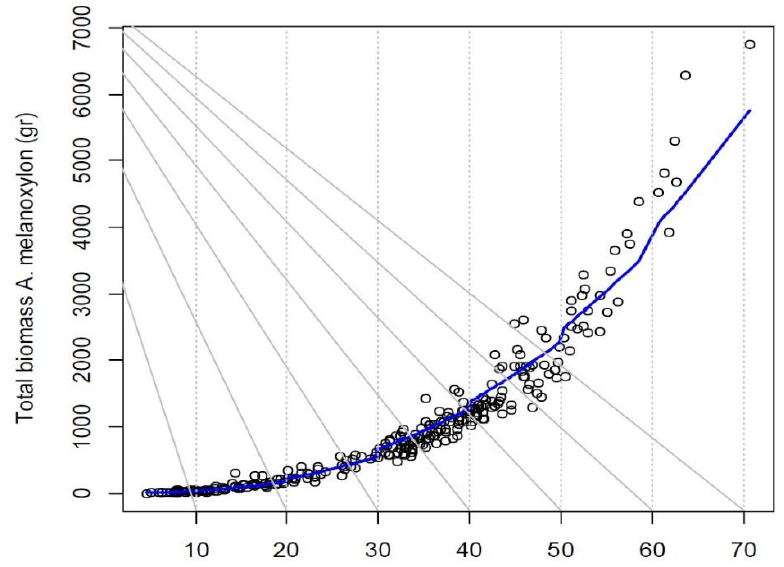
Figure 3. Adjustment of the total biomass of Acacia melanoxylon using the NSUR method as a function of the observed values. The line represents the values adjusted by DNH intervals, considering average height and age values for each diameter class.